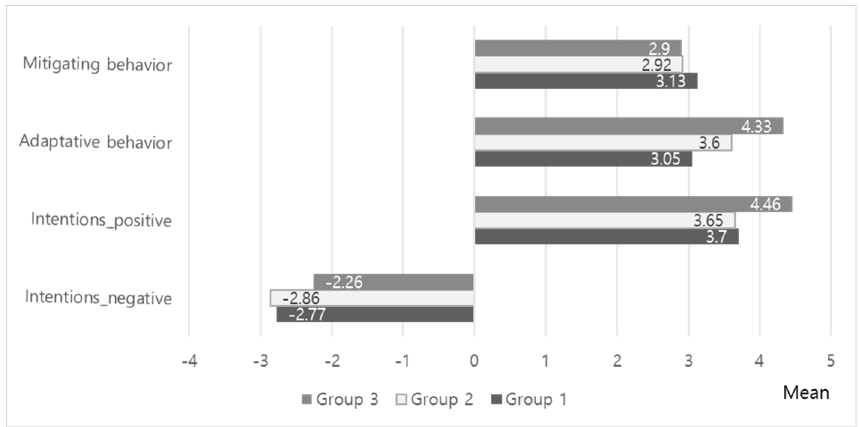
Figure 5. Residents’ response behaviors to particulate matter.